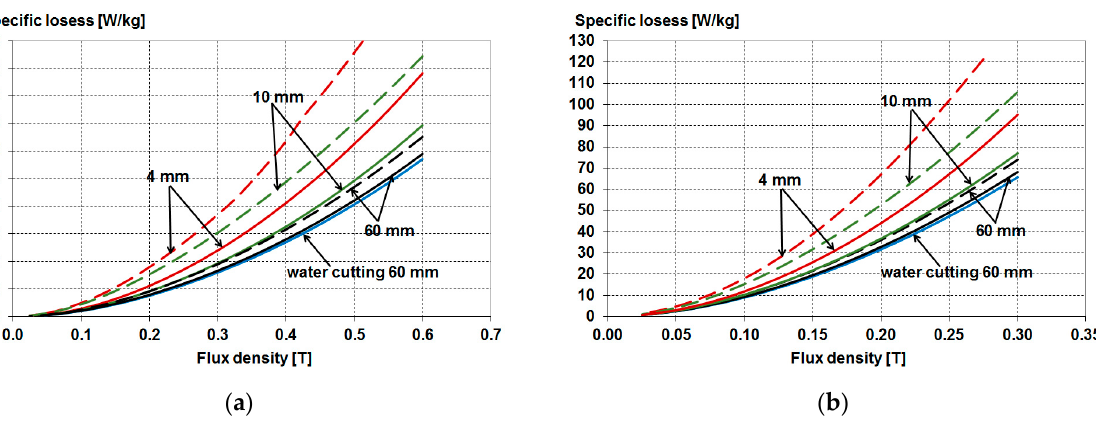
Figure 28. Measured at a frequency of 1000 Hz ( a ) and 4000 Hz ( b ) loss characteristics of the M 270-35A sheet for various widths of sheet samples cut with a guillotine (solid line) and samples cut with a laser (dashed line). Table 7. Comparison of the relative (referred to measured loss values of water-cut sample 60